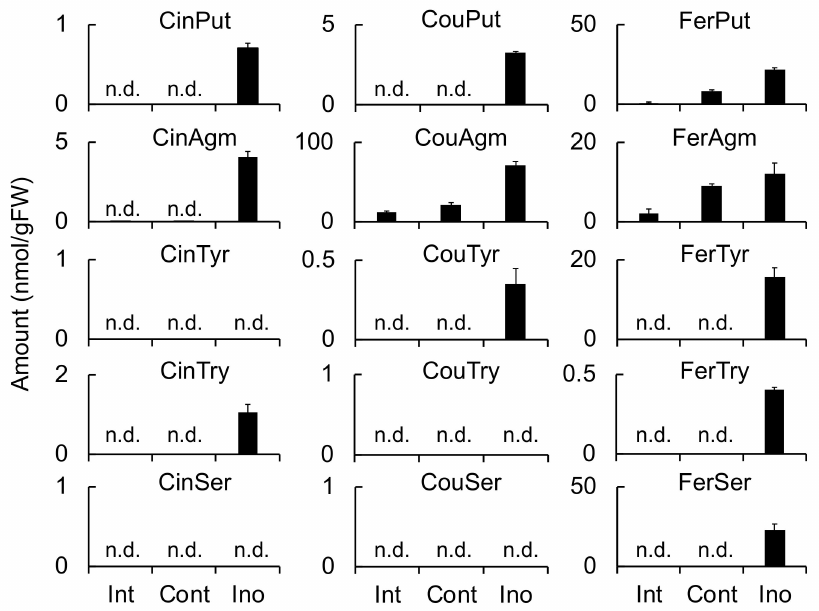
Figure 5. E ff ect of Bipolaris sorokiniana infection on the accumulation of phenylamides in barley leaves. Phenylamide levels were measured at 72 h after inoculation using MRM with LC-MS / MS. Values and error bars represent mean ± SD ( n = 3). Cont, control; Ino, inoculated with B. sorokiniana ; n.d., not